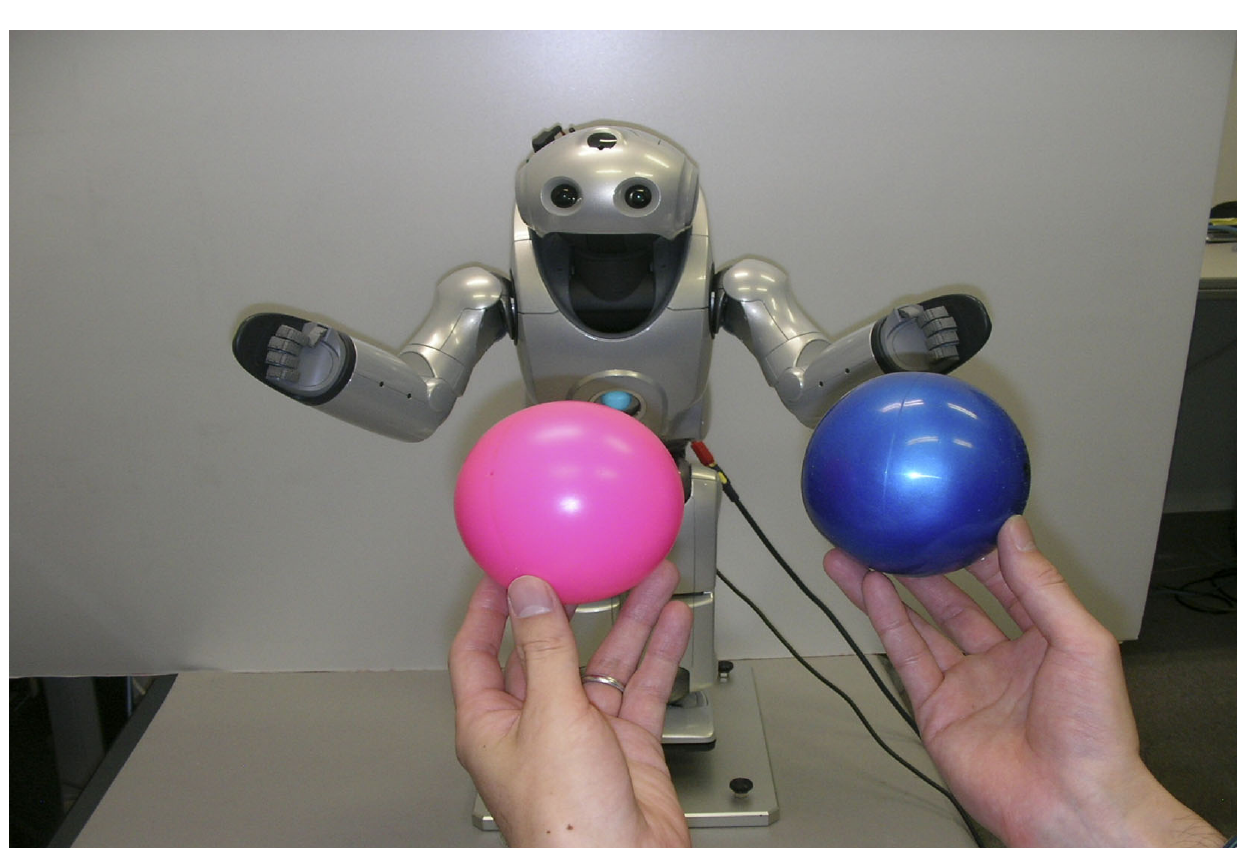
Figure 4. A user is interacting with the Sony humanoid